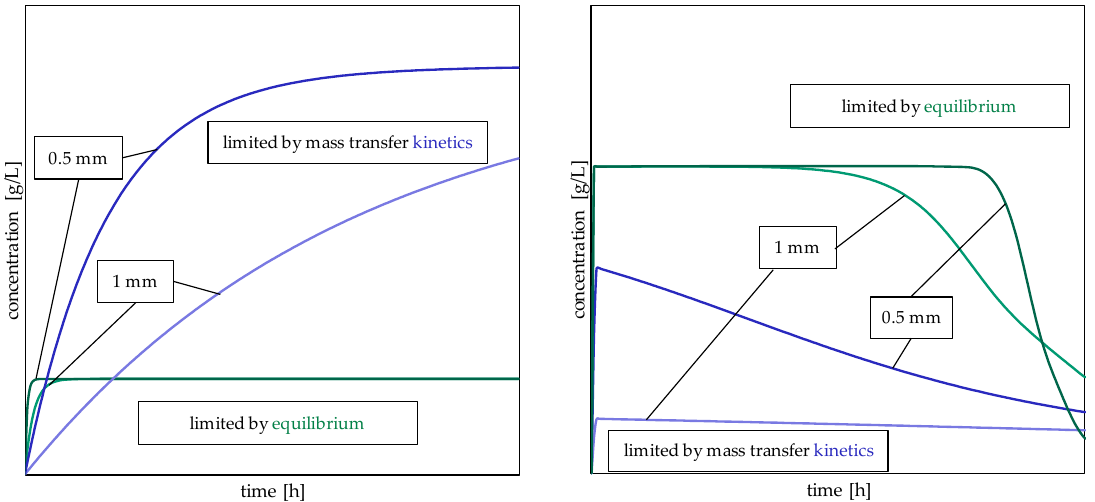
Figure 14. Concentration profiles for different limitations in a maceration process (left) and a percolation process (right).